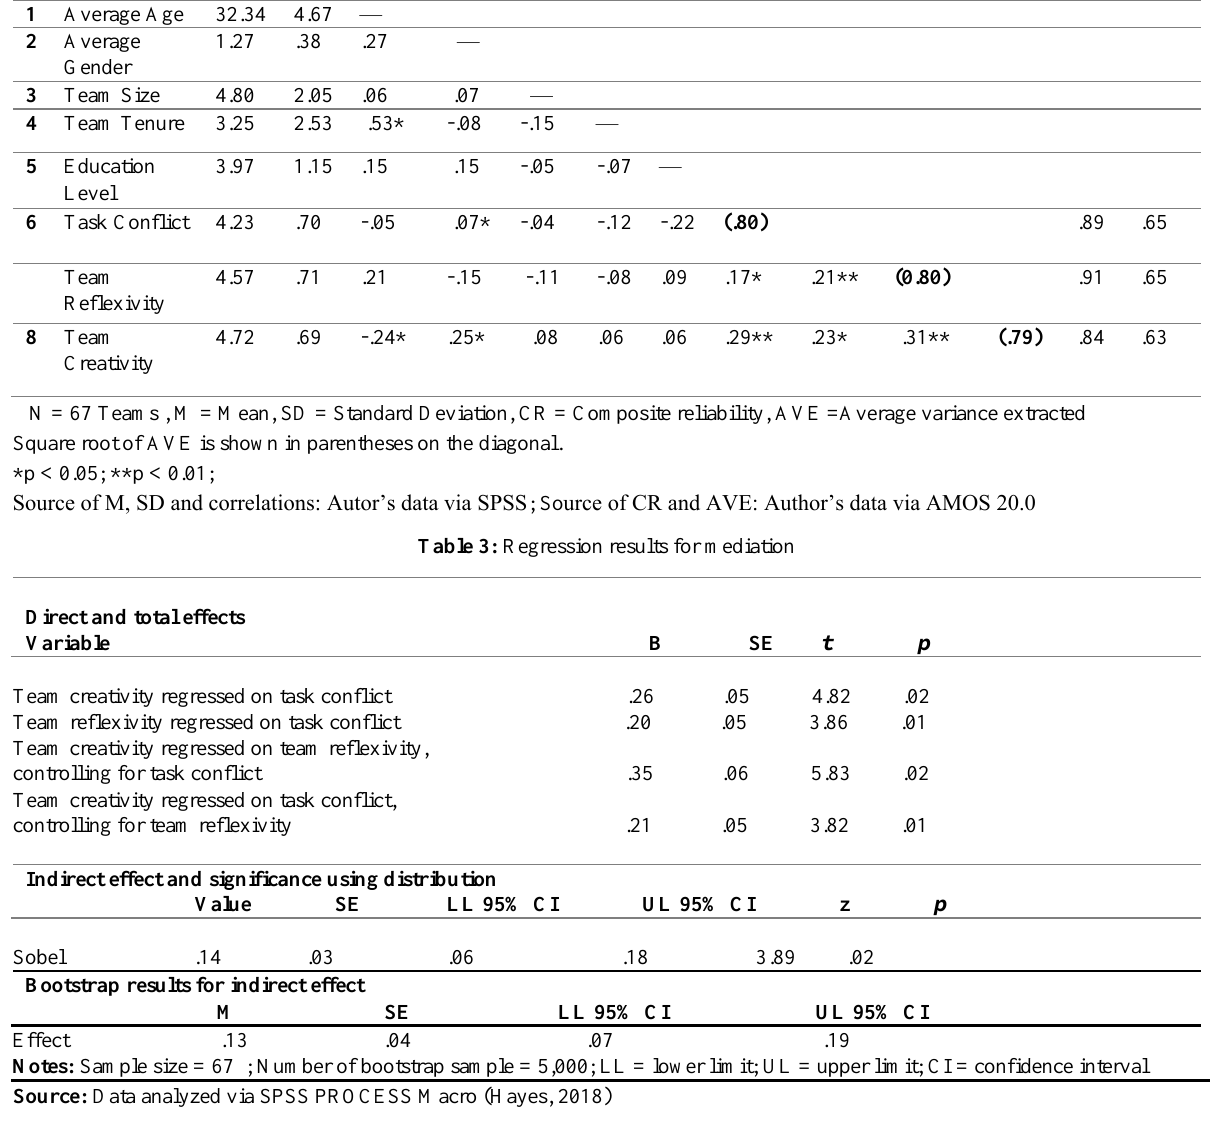
Table 2. shows the means, standard deviations, and inter-correlations for all control variables, independent variable, mediator and dependent variable, and also the square roots of AVE in diagonals.